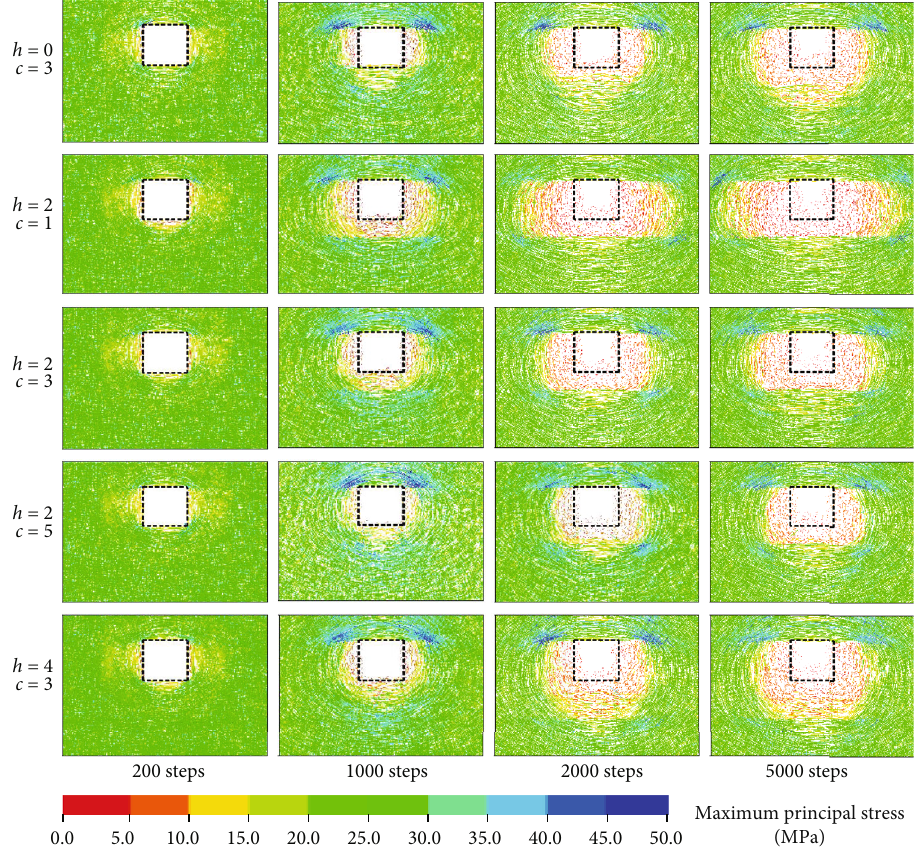
Figure 9: Time-varying evolution of stress tensor of the surrounding rock in the retained bottom coal roadway. Here, h = bottomcoal thickness (m) and c = coal cohesion (MPa), the same as in Figures 10 –